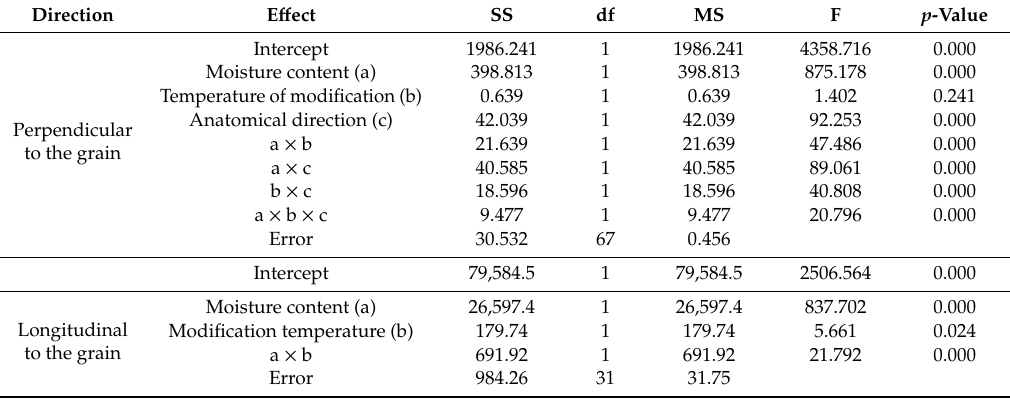
Table 3. Analysis of variance taking into account the e ff ect of moisture content, modification temperature and the anatomical direction on relative / compressive strength (R c ) perpendicular and longitudinal to the grain for thermally-modified ash ( Fraxinus excelsior L.) wood. Direction E ff ect